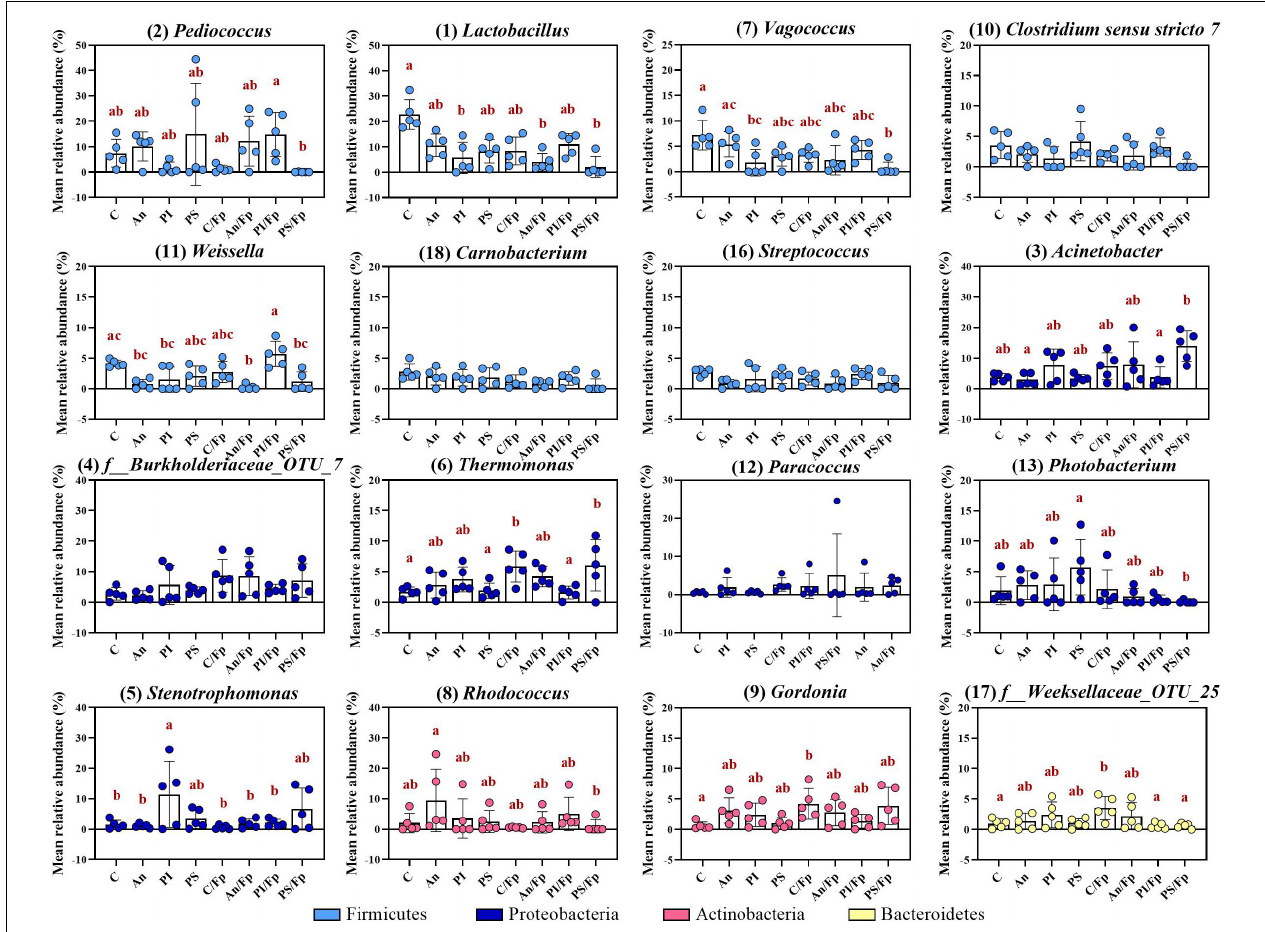
FIGURE 6 | Top-13 most abundant, plus three additional genera, selected among the top-30 in fish fed with control, antibiotic, phage-immobilized and phage-sprayed feed with (C/Fp; An/Fp; PI/Fp; PS/Fp) and without (C; An; PI; PS) bacterial exposure (1 dpi). The selection of the additional genera was based on previously observed abundances (among top-13 at day -1). The number in parenthesis states the position of the genus in the ranking. Values represent the mean and SD of five samples. Differences are tested by ANOVA or Kruskal–Wallis ( P -values are adjusted for multiple comparison). When significant, differences are presented with different red letters. See Supplementary Table 7 for more information on the top-30 most abundant genera at day